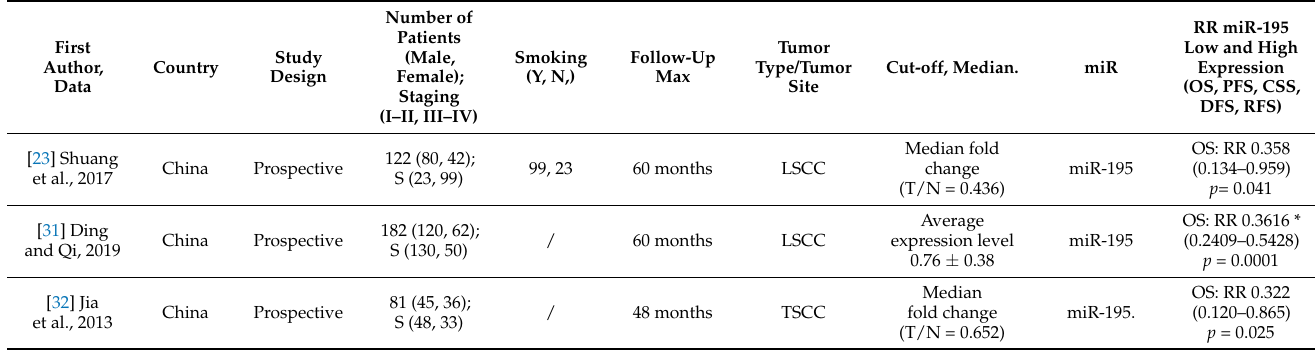
Table 1. The data extracted for the four articles included in the